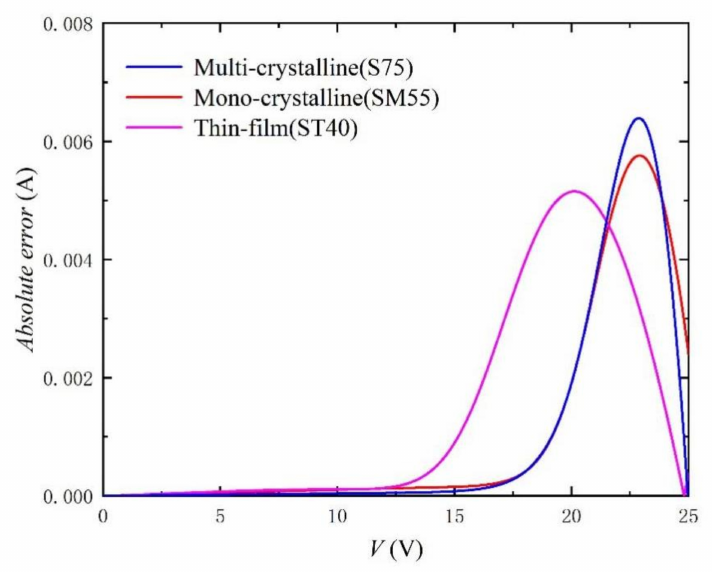
Figure 8. Absolute error curves between experimental data [33] and using the extracted parameters listed in Table 2.